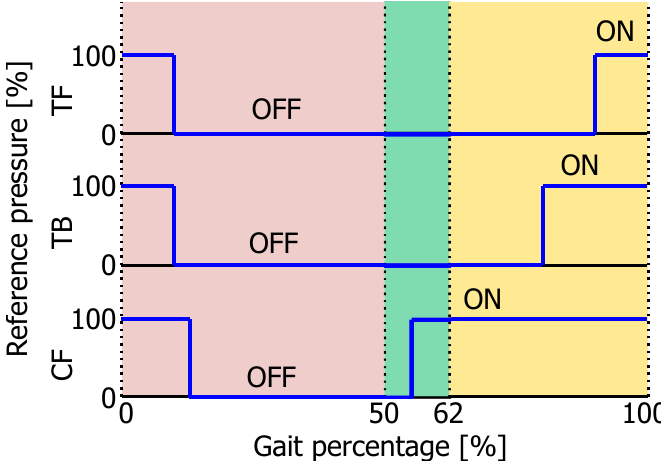
Figure 13. Pressure input time of PARMs controlled by servo valves. The horizontal axis shows gait percentage, and the vertical axis shows reference pressure in each PARM. ON (100%) and OFF (0%) mean the pressurized state and the depressurized state. Walking phases are distinguished by color areas. Red areas represent the stance phase, green areas represent the pre-swing phase, and yellow areas represent the swing phase. The pressurized timing and duration in each PARM are given from the EMG activation time in each muscle near the PARM